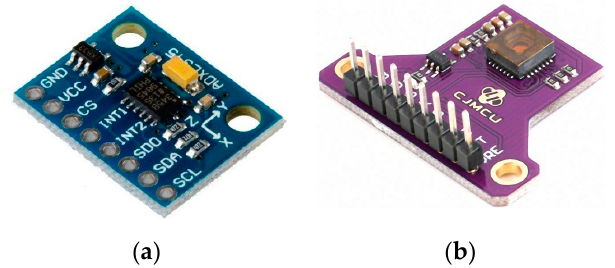
Figure 3. Used sensors: ( a ) ADXL345 accelerometer [33]; ( b ) PMW3901 optical flow sensor [34].